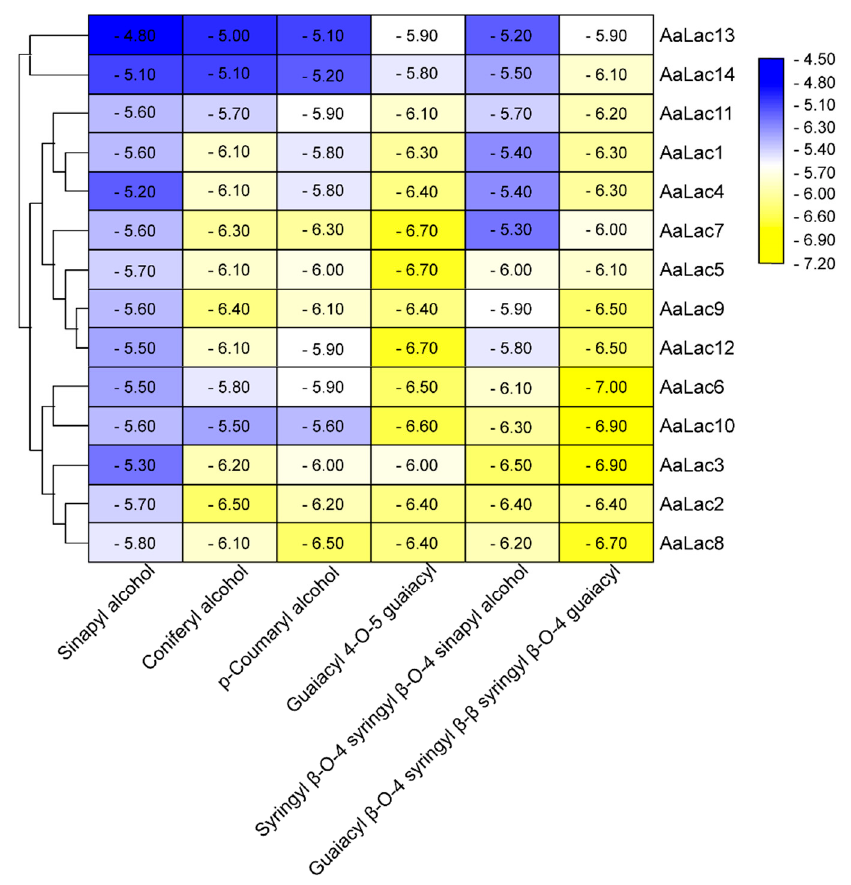
Figure 5. The minimum binding energy scores (kcal / mol) of A. areolatum laccases with lignin model compounds.